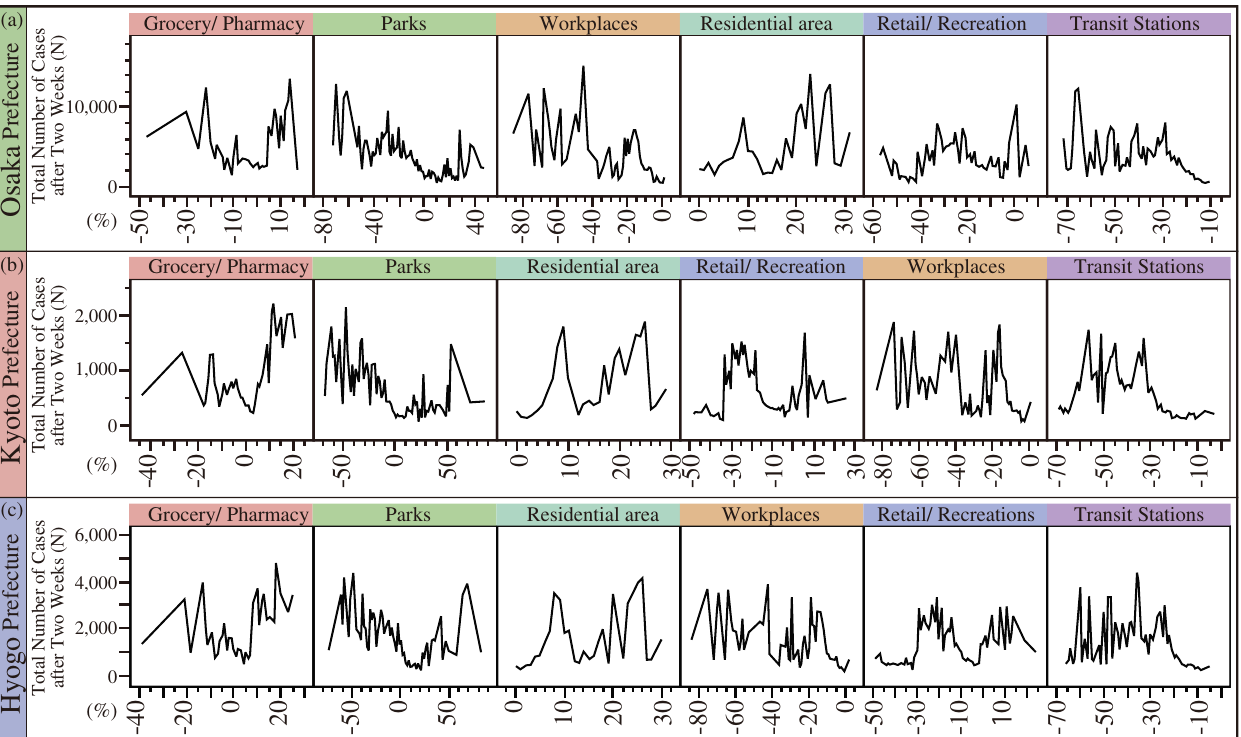
Fig. 4 Variable importance by prefecture. The variable importance is assessed by the dependent resampled inputs, which are factor values constructed from observed combinations using a k-nearest neighbors approach. In Fig. 4, ( a ) indicates the variable importance of Osaka prefecture, ( b ) indicates that of Kyoto prefecture, and ( c ) indicates that of Hyogo